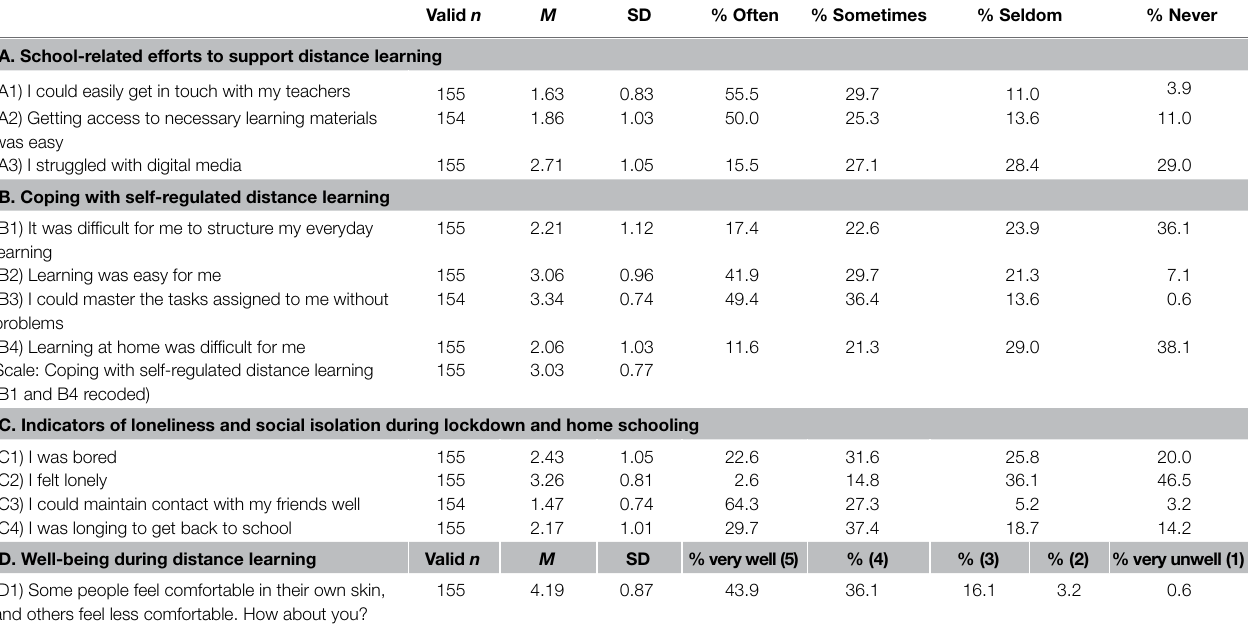
TABLE 2 | Descriptive statistics on students’ perceptions of distance learning and lockdown. Valid n M SD %